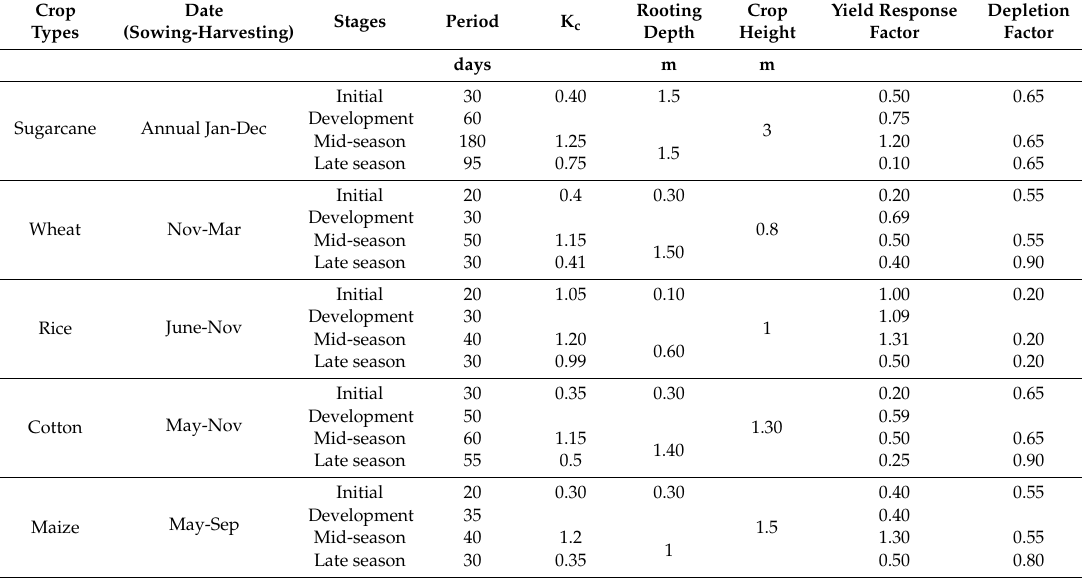
Table 2. Multi crop information parameters used in the CROPWAT model to compute Crop Irrigation Requirement (CIR) of five major crops grown in Rechna